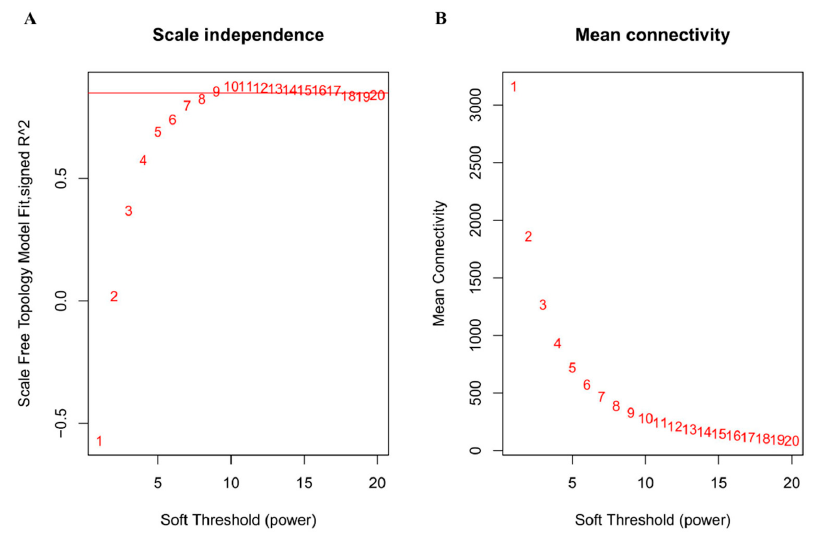
Figure 2. The determination of soft thresholding power. ( A ) is a scale-free fitting index (y-axis) responding to various soft-thresholding powers (x-axis). ( B ) represents the mean connectivity (y-axis) of different soft-thresholding power (x-axis). The approximate scale-free topology can be obtained at the soft-thresholding power of 9.